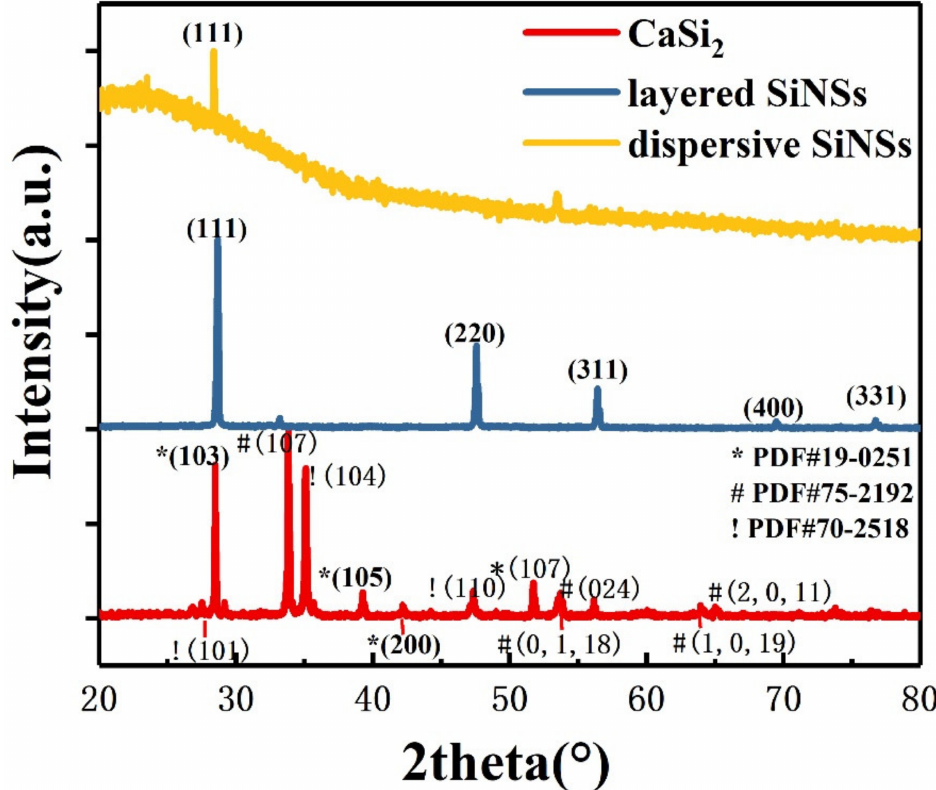
Figure 1. X-ray diffraction (XRD) spectrum of the original reactant CaSi 2 (red line), as-prepared layered silicon nanosheets (blue line) and dispersive silicon nanosheets (yellow